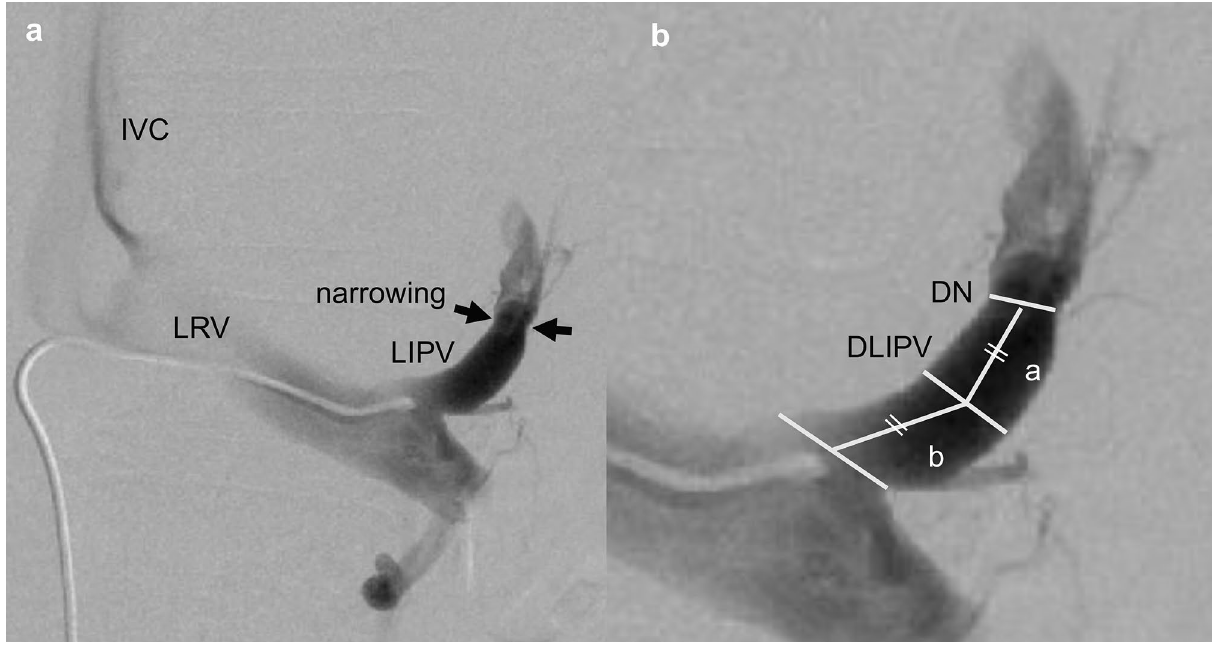
Figure 2. ( a ) Venogram of LIPV during BRTO. ( b ) The diameter of LIPV was measured at the midpoint between narrowing and the outlet of LIPV. The diameter of narrowed LIPV was measured at a narrow portion that was the closest to the outlet of LIPV. The distance to narrowed LIPV was defined as the distance from narrowed LIPV to the midpoint (= a) + the distance from the midpoint to the outlet of LIPV (= b). IVC, inferior vena cava; LRV, left renal vein; LIPV, left inferior phrenic vein; LARV, left adrenal vein; DN, Diameter of narrowed LIPV; DLIPV, Diameter of the left inferior phrenic